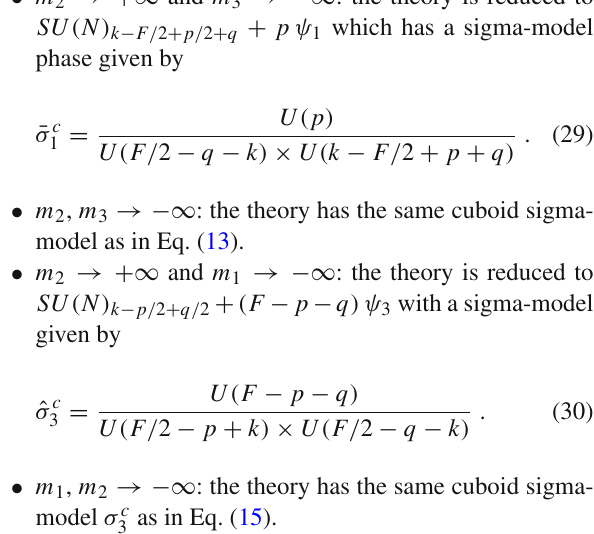
, σ c , and σ c 1 2 3